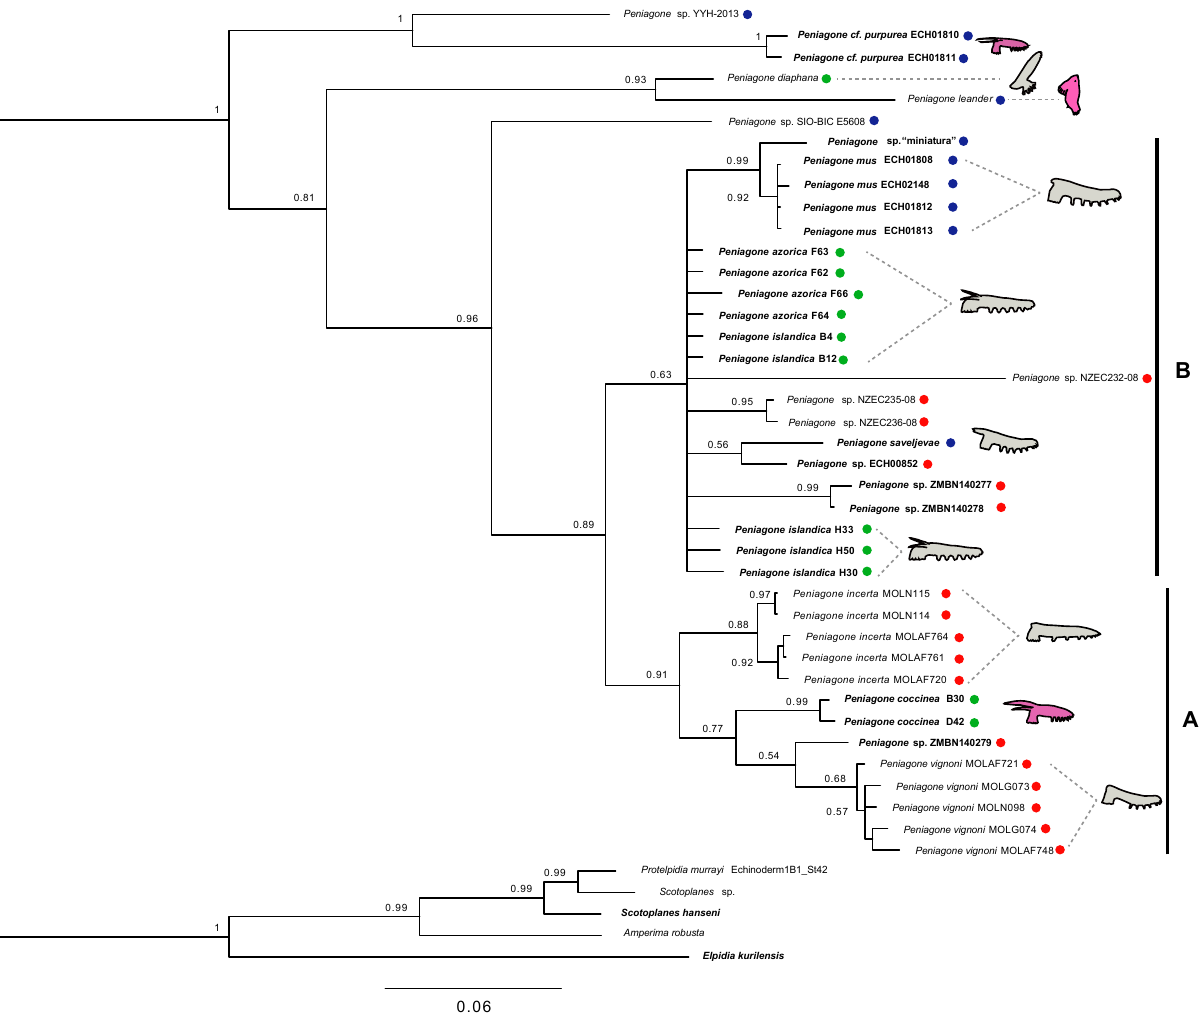
Figure 10. Bayesian phylogenetic tree inferred from concatenated mtDNA COI and 16S RNA sequences. Sequences obtained in this study are in bold. Node numbers are posterior probabilities. NZEC2XX-08 correspond to BOLD process ID numbers. Holothurian pictograms are colored according to the color of preserved specimens. Colored circles correspond to geographical locations as on Figure 9.